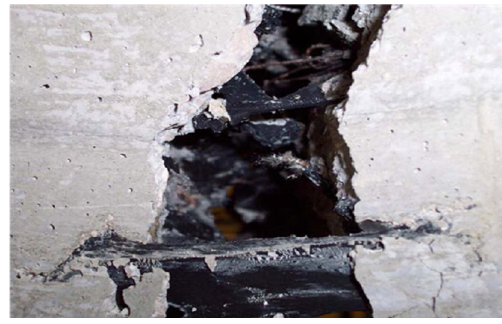
Fig. 9 Crack behavior of concrete beam after flexural